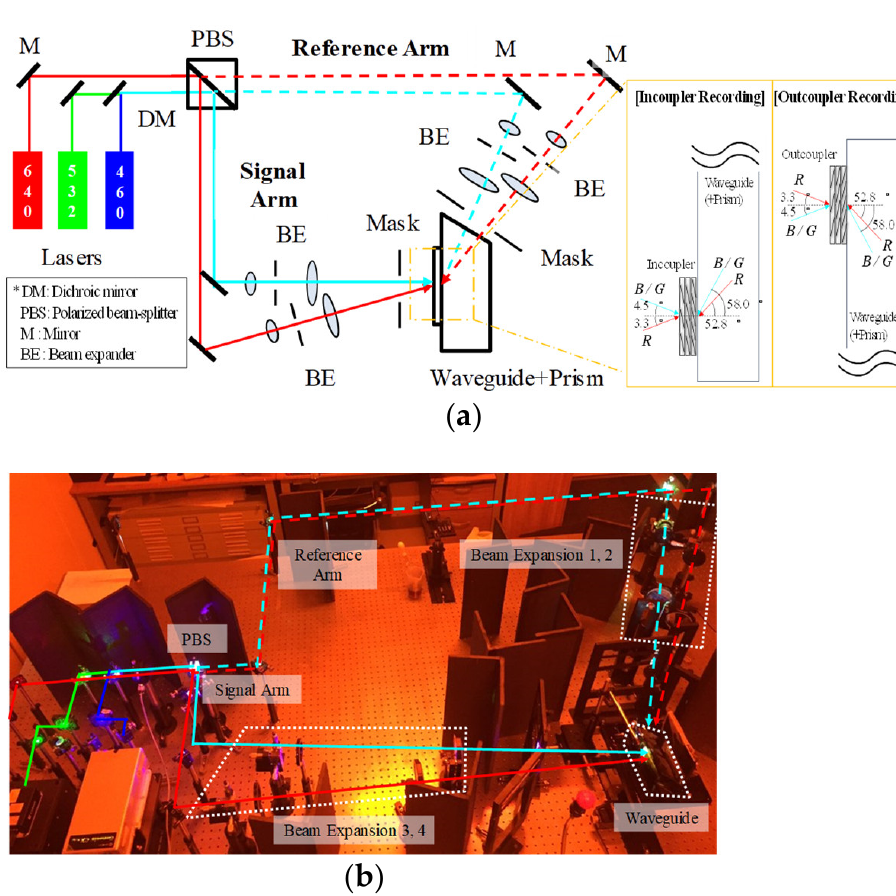
Figure 6. Experimental setup for recording HOEs: ( a ) the schematic, and ( b ) the picture of optical setup for recording the HOE couplers on the holographic waveguide.